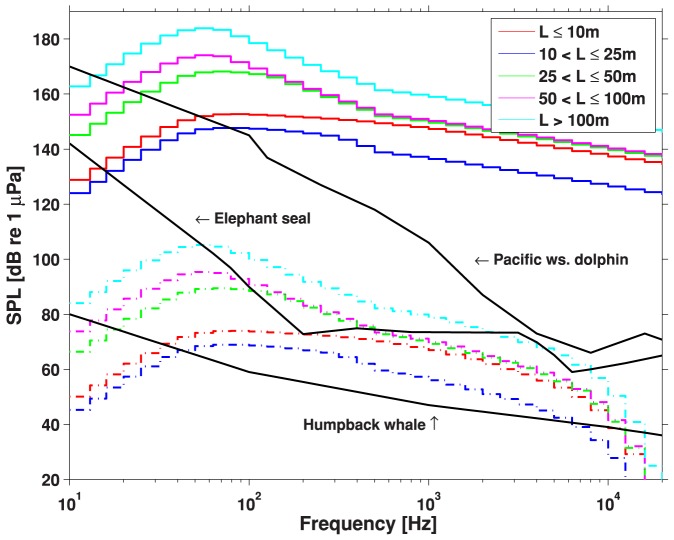
Ship source spectra (1/3 octave band levels) for five vessel length classes (solid lines) in dB re 1 µPa @ 1 m.Note that vessels <10 m length were louder than vessels up to 25 m length due to the faster mean speed of the shorter vessels. Received spectra at 30 km range in 50 m of water (dash-dot lines), in dB re 1 µPa. Marine mammal audiograms from Fig. 2 (black lines) in dB re 1 µPa.